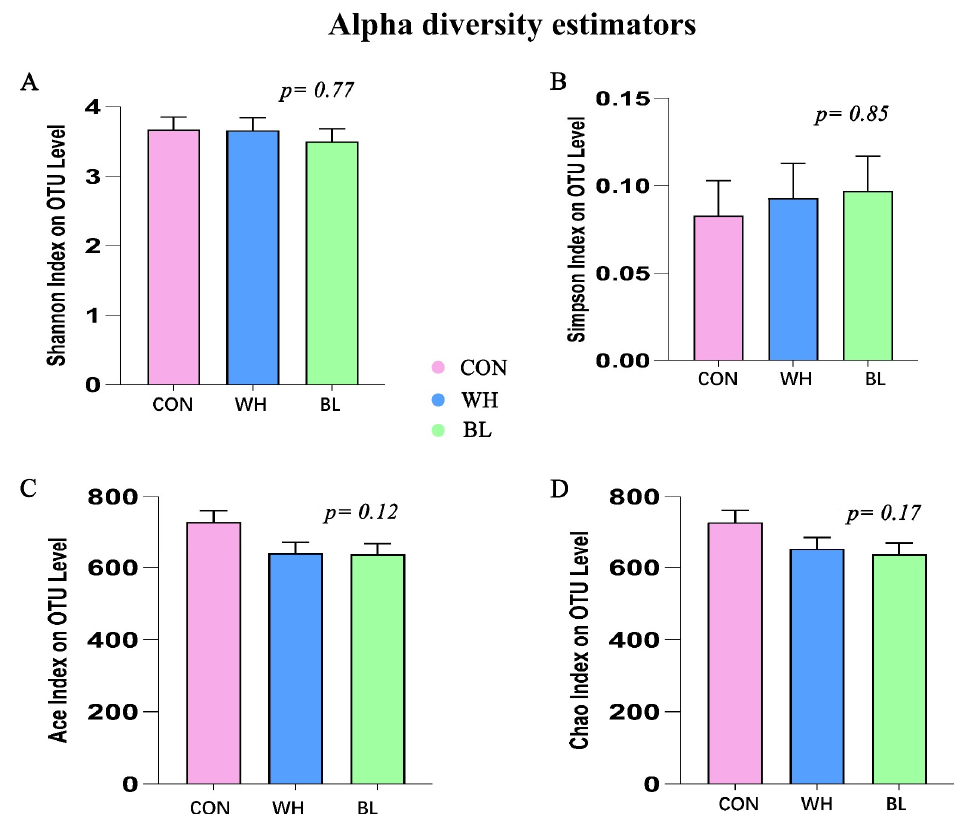
Figure 2. Effects of the partial substitution of corn by wheat or barley on the alpha diversity of bacterial flora in the feces of growing pigs. ( A ) Shannon index, ( B ) Simpson index, ( C ) Ace index, ( D ) Chao index. The individual pig was regarded as the experimental unit (n = 6). CON, basal diet group; WH, wheat diet group; BL, barley diet group.